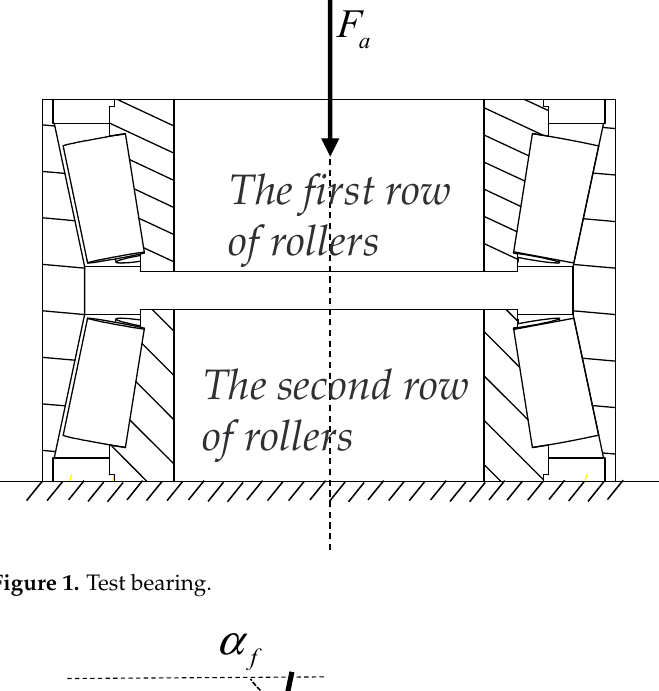
Figure 1. Test bearing.